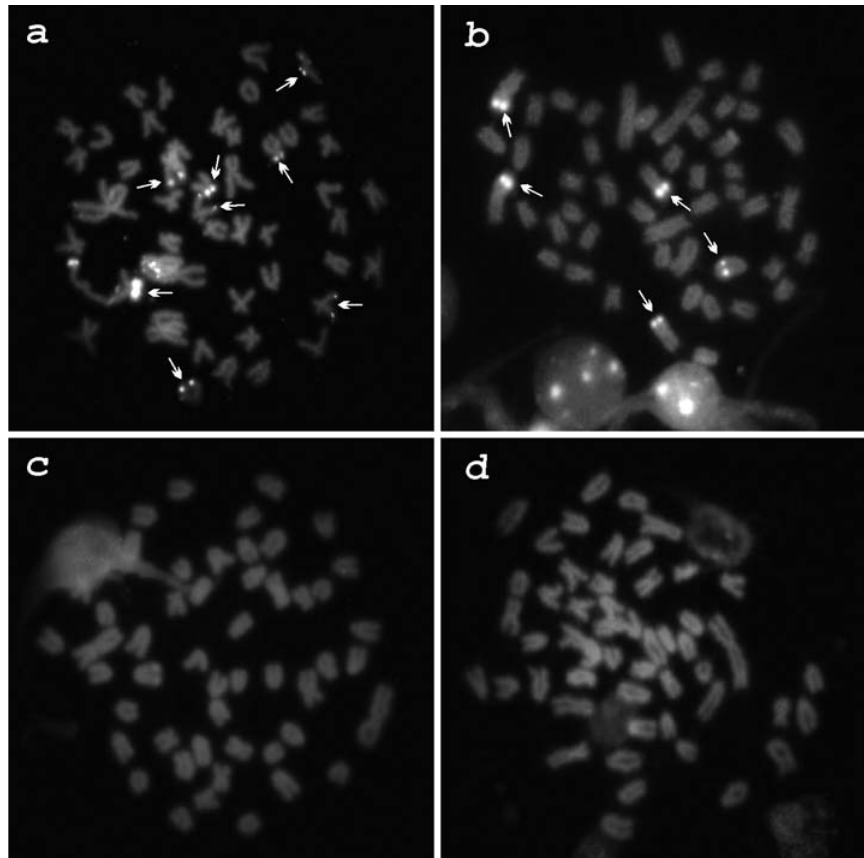
Figure 3 - Fluorescence in situ hybridization with As-51 satellite DNA probe. The arrows indicate these sites in: (a) A. scabripinnis ; (b) A. parahybae . In (c) and (d) it is showed lack of signals of the satellite DNA correspondence in A. intermedius and A. giton ,